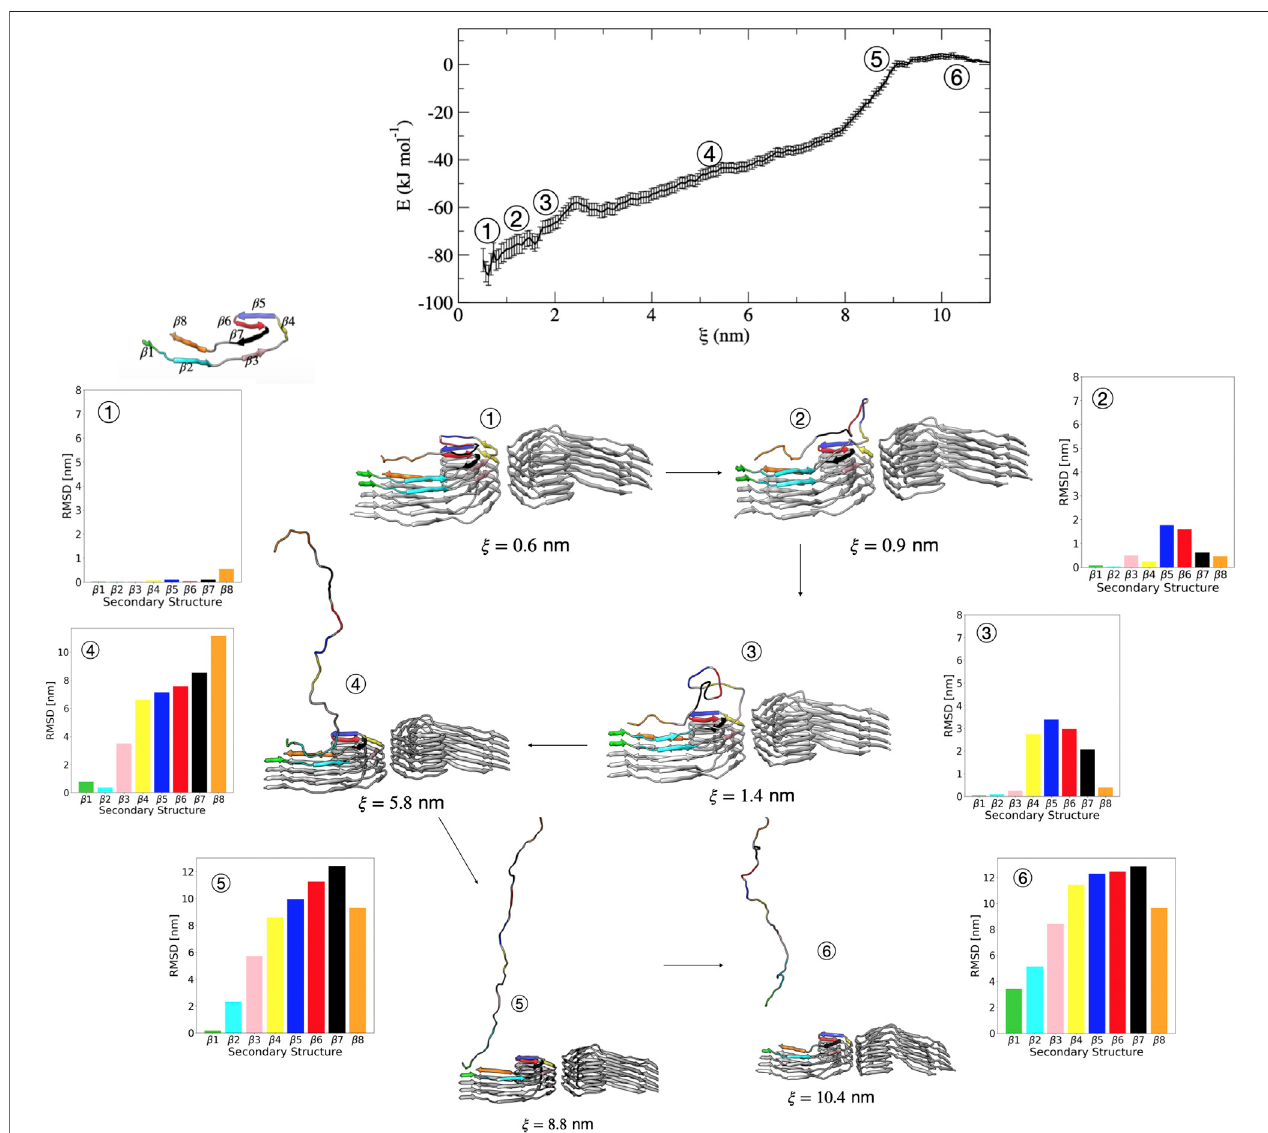
FIGURE 5 | Free energy pro fi le for the association/dissociation of a single tau chain onto the PHF proto fi bril. Representative structures are shown along with the dRMSDofthesecondarystructureregions.Betweenstructures1and2thedRMSDincreasesfor β 5(blue), β 6(red),and β 7(black).Structure3showslossof β 4(yellow), and structure 4 shows loss of the β 3 (pink). Structure 5 shows loss of β 2 (cyan). The complete dissociation occurs with loss of β 1 (green) that includes the PHF6 region. Structureswereobtainedfromumbrellasamplingsimulationwindowwithinthedifferentregionsalongthereactioncoordinateafter5 ns.ThedRMSDvaluesineachofthebar graphs are calculated from Eq. 1 for the depicted representative structures taken at 5 ns of simulation, where the fi nal folded state is the reference structure.